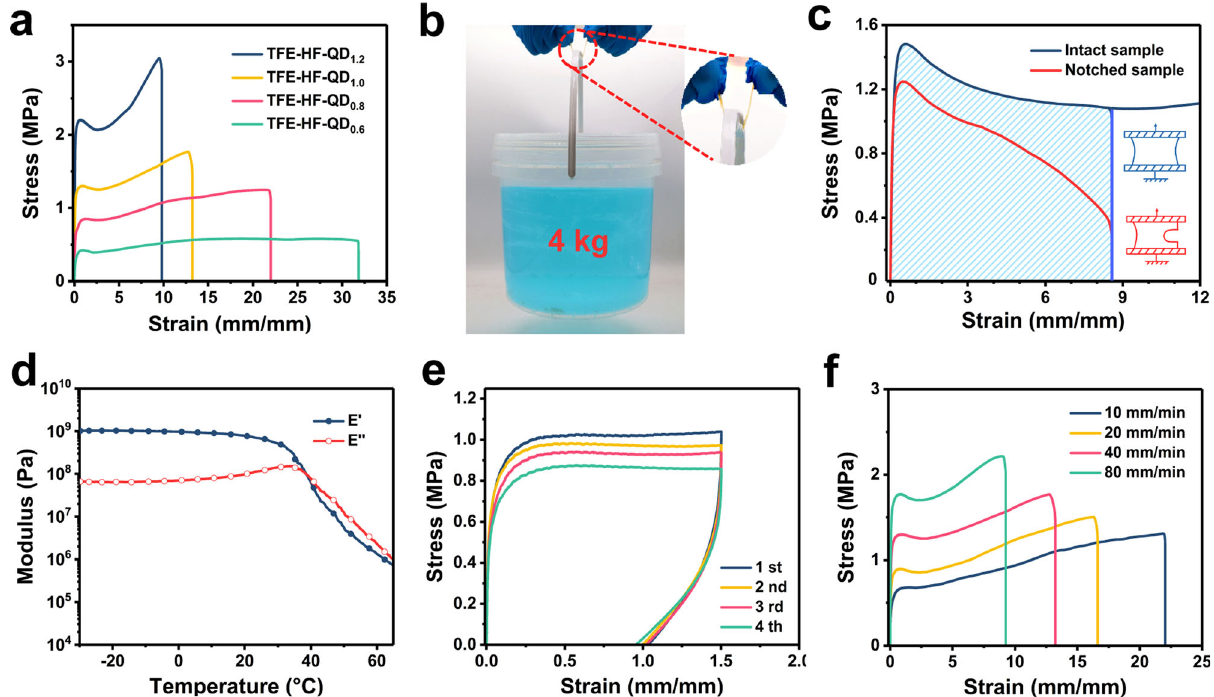
Fig. 3 Mechanical properties of TFE-HF-QD. a Stress – strain curves of various TFE-HF-QD x elastomers. b A demonstration of the mechanical strength of TFE-HF-QD 1.0 . c The fracture energy of TFE-HF-QD 1.0 . d The storage modulus (E') and loss modulus (E'') of TFE-HF-QD 1.0 elastomer as a function of temperature. e Cyclic loading and recovery of TFE-HF-QD 1.0 . f Stress-strain curves for TFE-HF-QD 1.0 samples when stretched at different